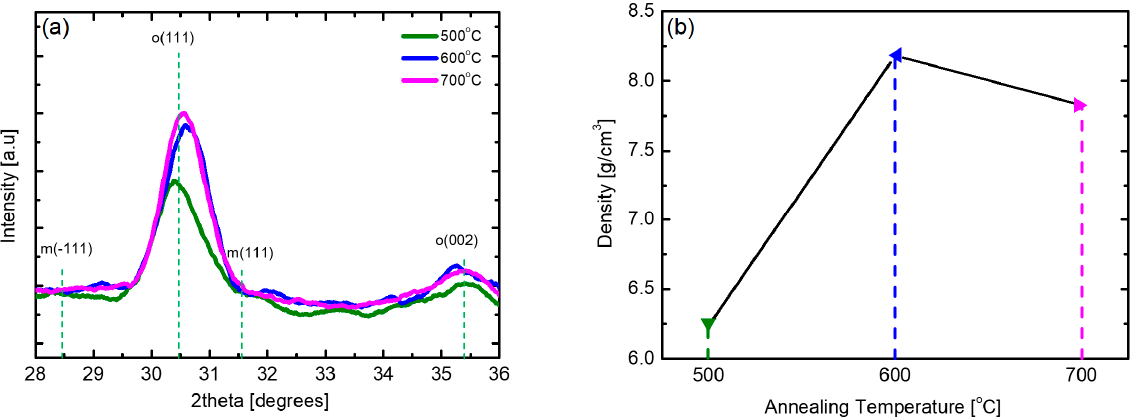
Figure 5. ( a ) XRD pattern and ( b ) density according to post-annealing temperature of PEALD HZO thin films deposited at 180 °C.